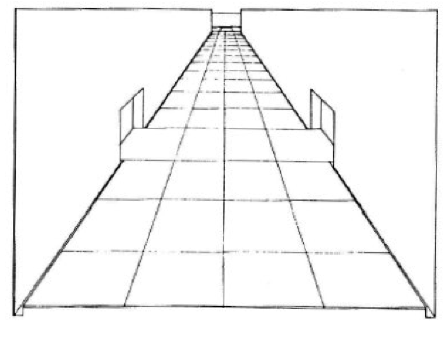
FIGURE 20 | J. Carreira, Route of the Discoverers, 1988,